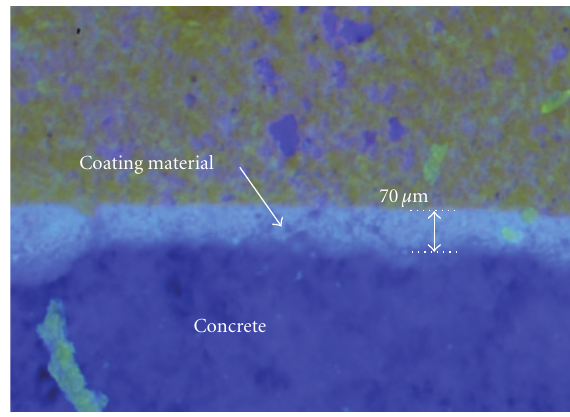
Figure 5: Thickness of coating material on surface concrete.